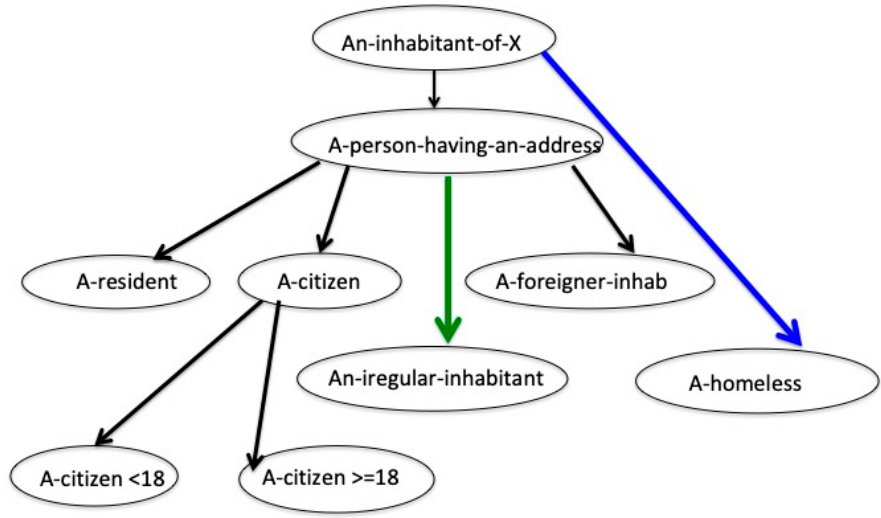
Figure 4. The objects lattice of the object “An inhabitant of a city X”.